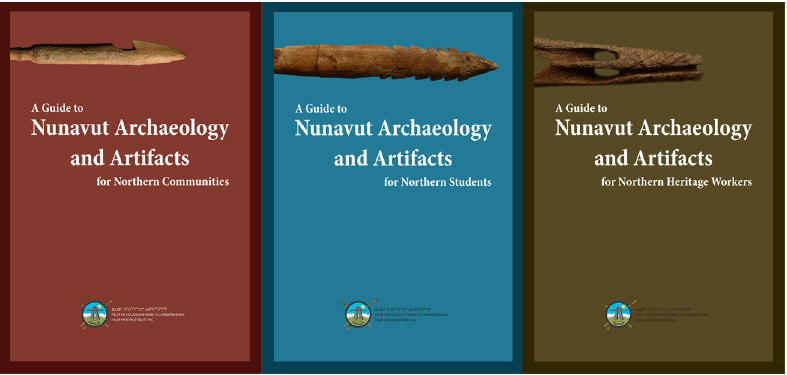
Figure 1: A Thule archaeological site located near Iqaluit, Nunavut that is under threat by camping and harvesting activities. Photo by Torsten Diesel.